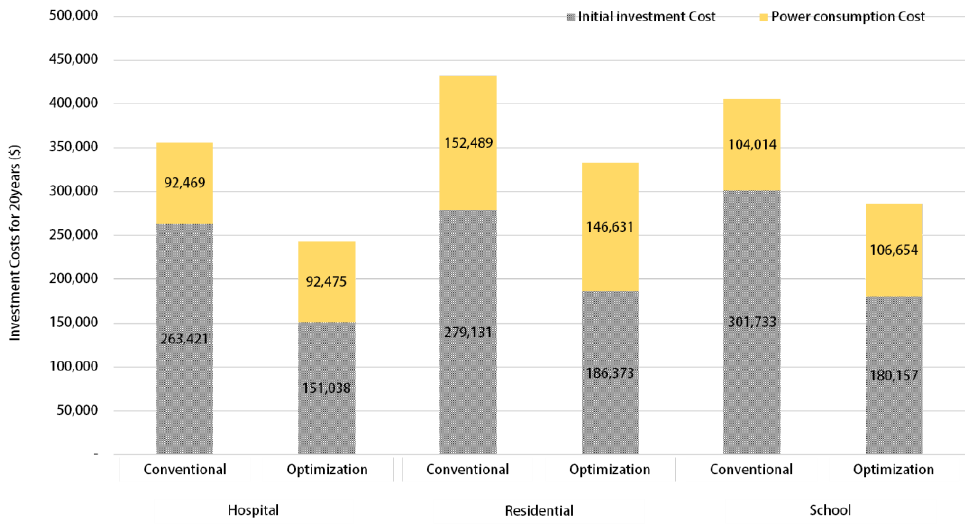
Figure 18. Comparison of the total cost over 20 years according to the optimization results by building type.